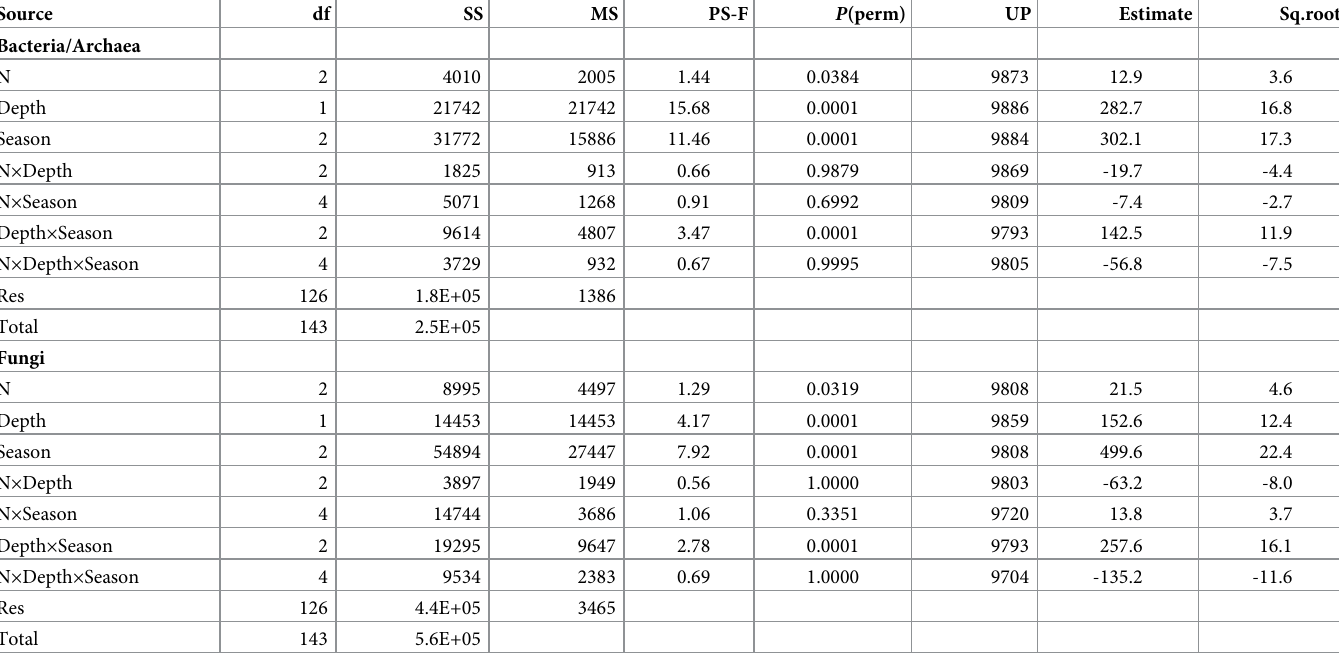
Table 1. Three-factor PERMANOVA results for differences in bacterial/archaeal and fungal community structure affected by three N fertilization levels (0, 100, and 200 kg N ha -1 ), two soil depths (0–5 and 5–15 cm), and three sampling seasons following N input (Spring, Summer, and Fall